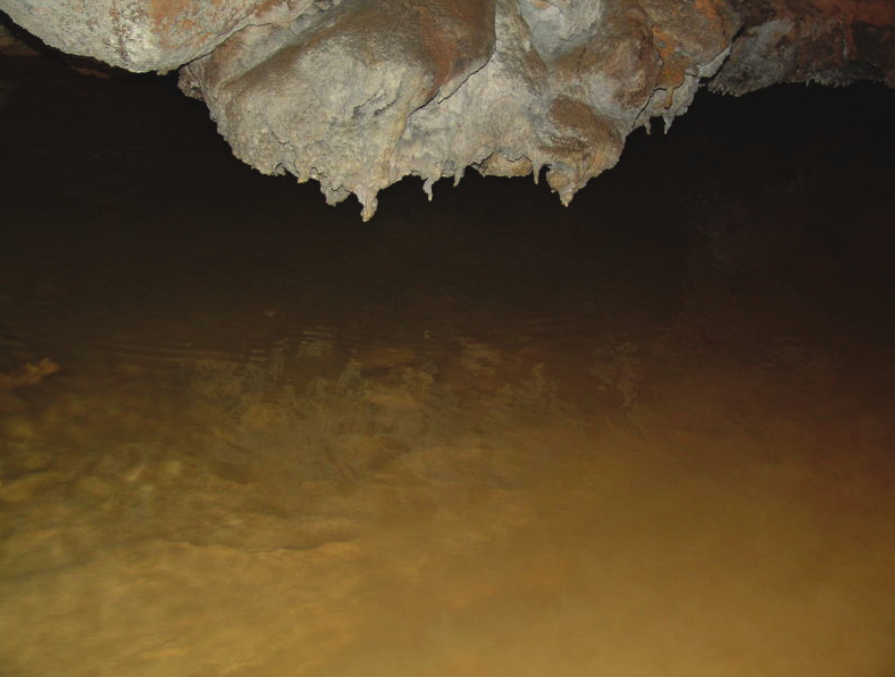
depressed pelvic fin reaching anus. Anus short distance from anal-fin origin. Caudal fin forked, tips